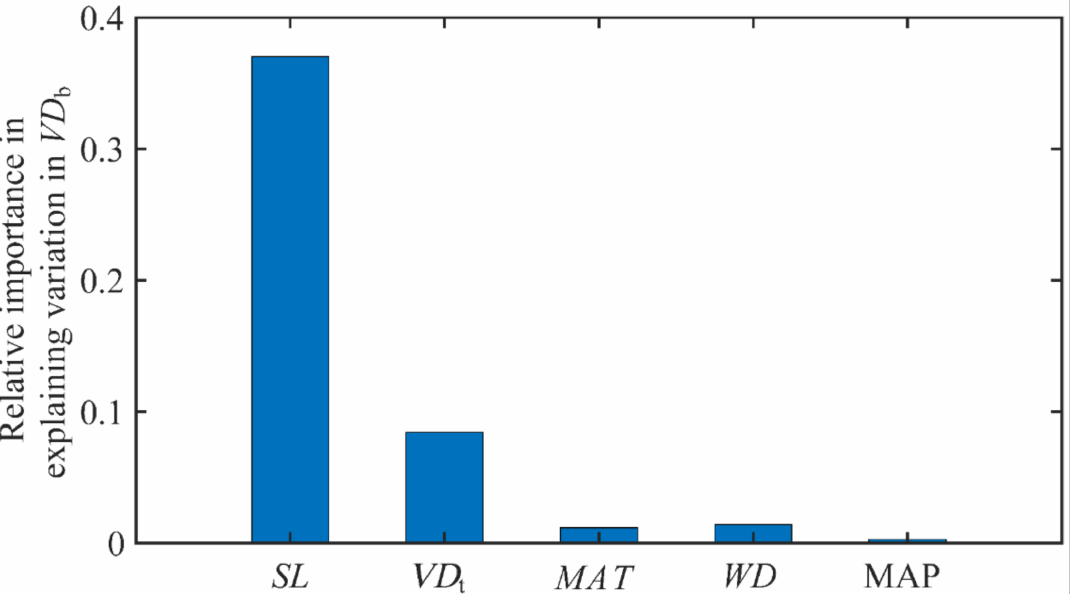
Figure 2. Relative importance of two climatic variables, VD t and SL , as well as WD in explaining VD b variation. All these variables were standardized before performing a multiple linear regression, so that the squared standardized coefficients ( β 2 ) depict the relative importance of explanatory variables. Abbreviations for traits and environmental variables are the same as in Table